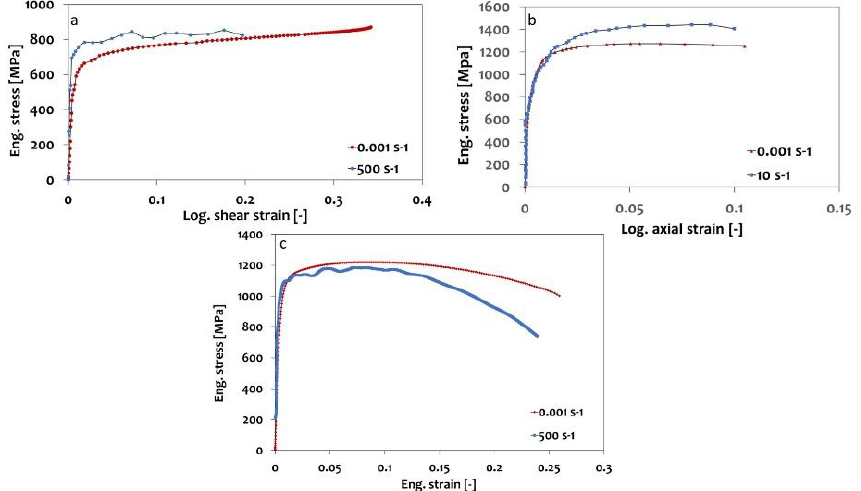
Fig. 4. Representative stress-strain curves of a) static and dynamic in-plane shear tests, b) static and intermediate plane strain tests and c) static and dynamic tests on dogbone samples